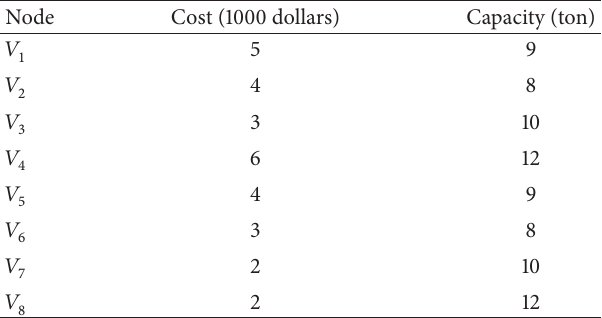
Table 1: The data of nodes for the 8-node